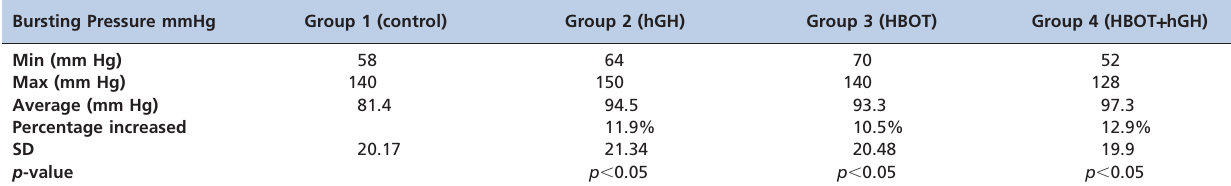
Table 1 - Bursting pressures in the non-ischemic groups. All of the values are expressed as the means ¡ SDs; SD: standard deviation. The p -value compares group 1 (control) to the other groups.